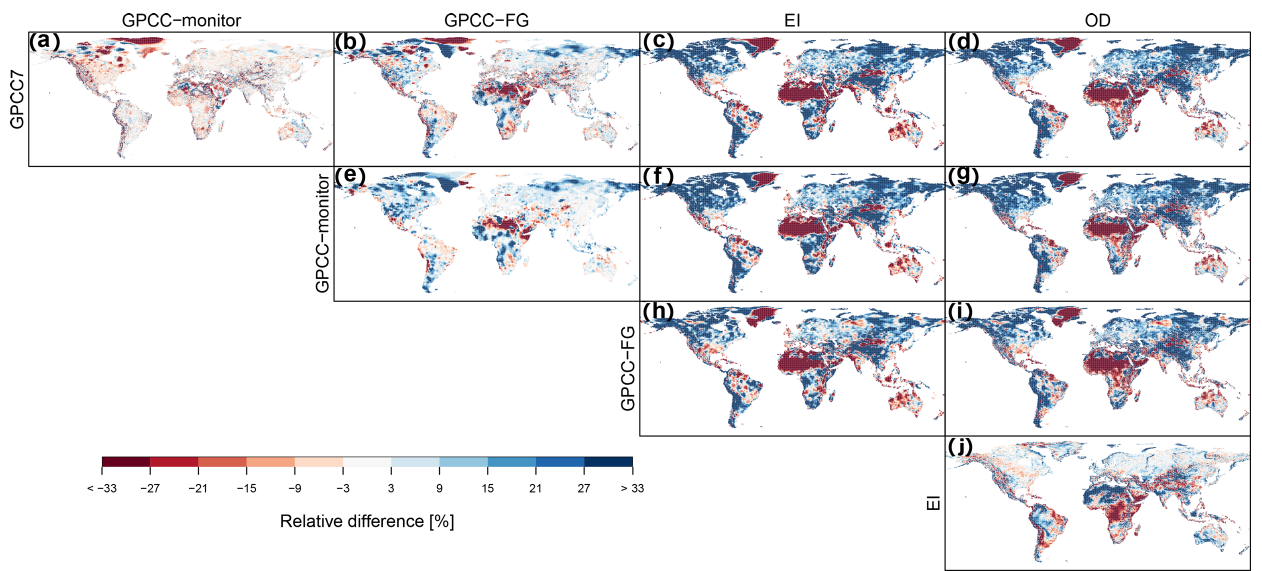
Figure 4. Relative difference of mean monthly precipitation between different data sources and (a–d) GPCC7, (e–g) GPCC-monitor, (h– i) GPCC-FG and (j)